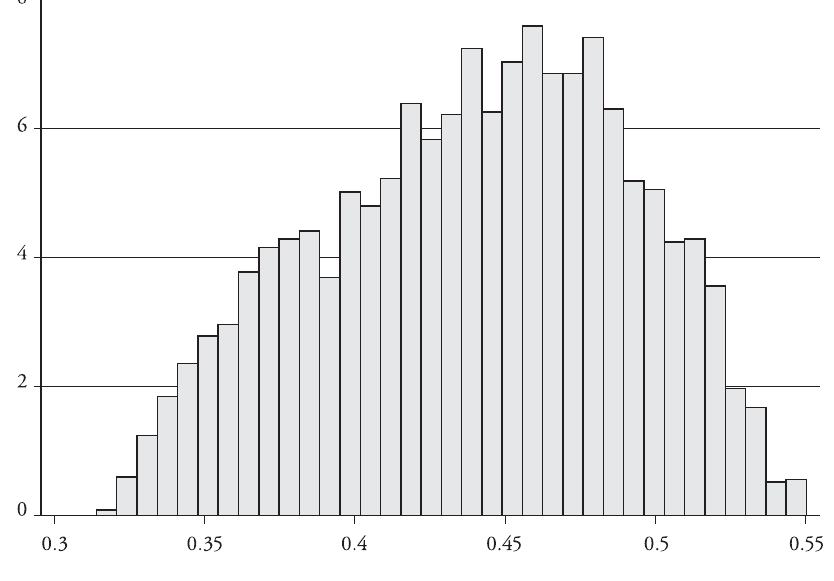
Figure 1: Histogram of Estimated Female Resource Shares